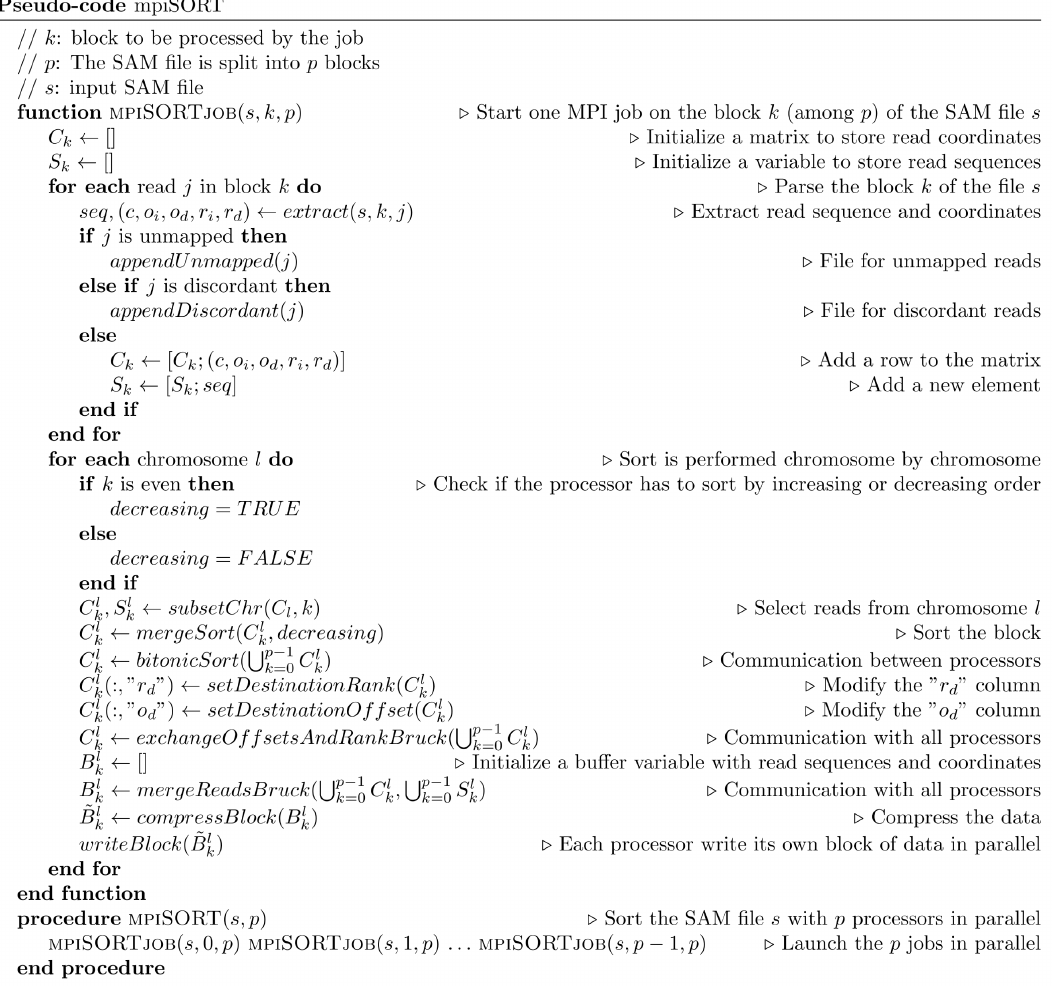
(Bruck et al ., 1997) of time complexity (log 2 p ). The Bruck algorithm is performed twice as shown in Figure 5 and can be seen as a joint procedure between two tables (the elements of the table being located on different processors). During the first Bruck phase, the r and o are sent back to the corresponding processor from where d d the data originated, and then, during the second Bruck phase, all the data (i.e. the appropriate lines of the SAM file) are sent to the processor that has been assigned to write the data. During the second phase the original data is copied into the memory buffer and then